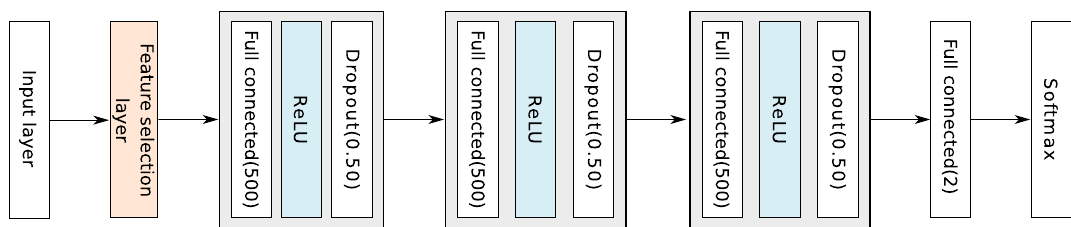
Figure 2. The network structure for gene selection used in Task 1 and Task 2. Task